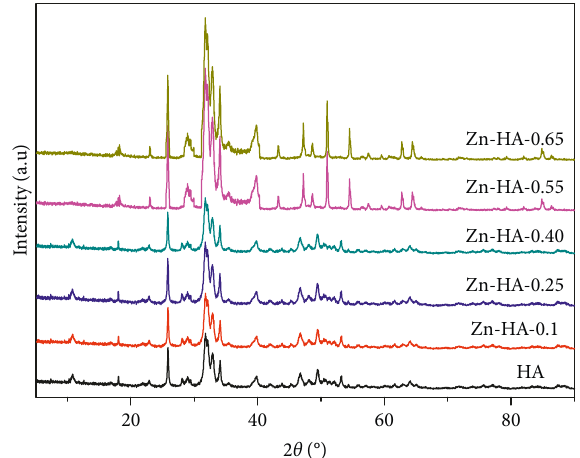
Figure 1: XRD patterns of HA and Zn-HA samples with different Zn